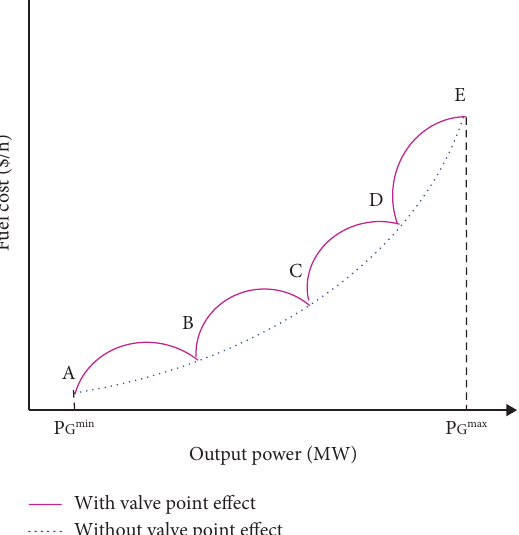
Figure 2: Cost curves of a generator with and without a valve-point